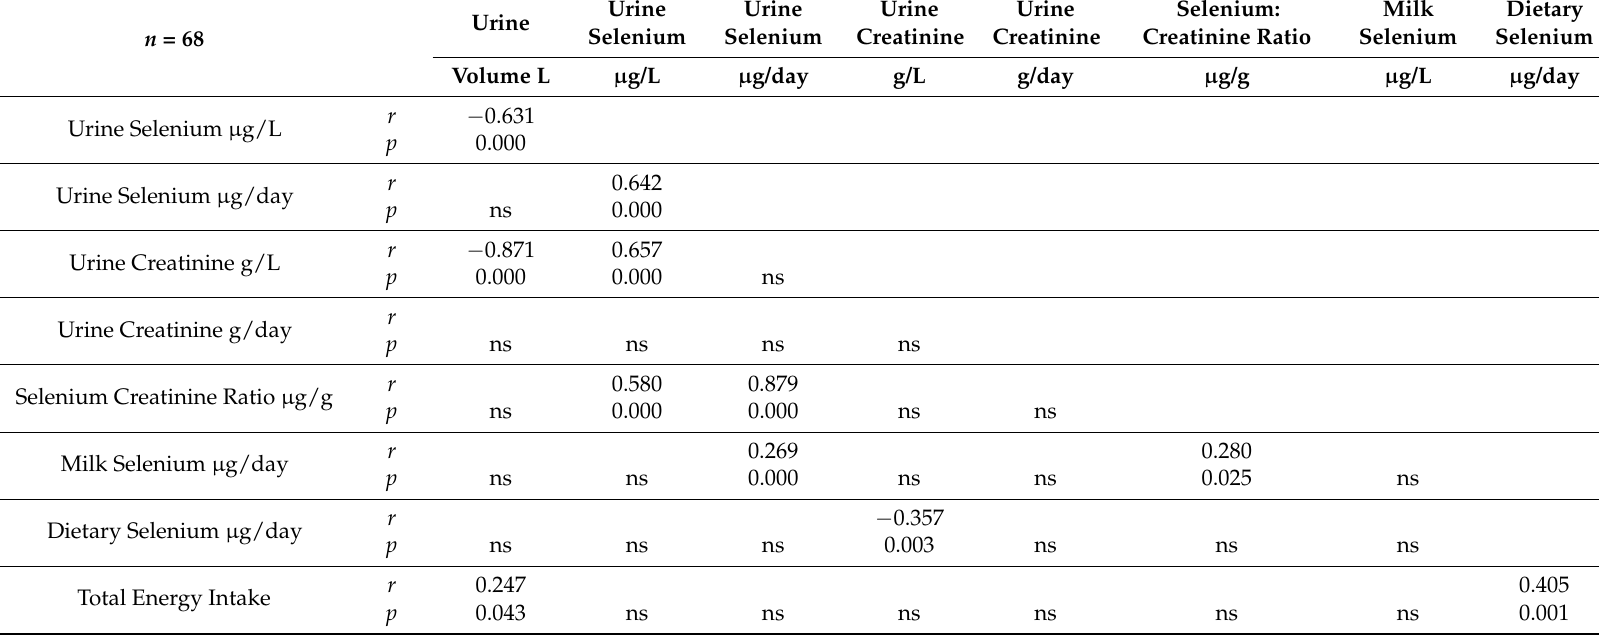
Table A2. Correlation matrix for selenium and creatinine in 24-h urine samples in breastfeeding women using Spearman’s rho.